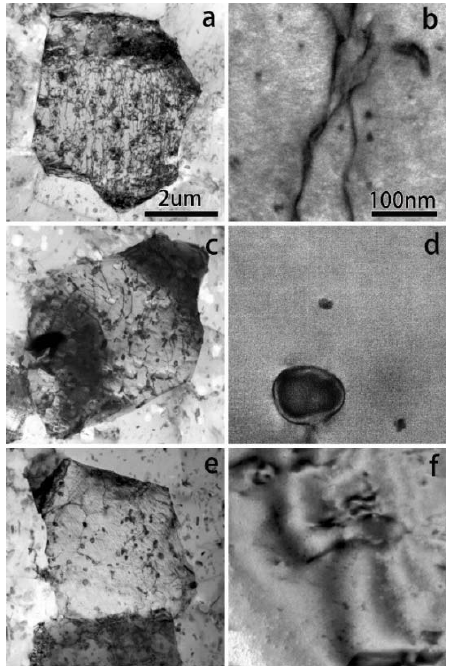
Figure 7. Microstructures in the weld nugget zone: ( a , b ) in the advancing side; ( c , d ) in the center; ( d , e ) on the retreating side. Metals 2018 , 8 , x FOR PEER REVIEW